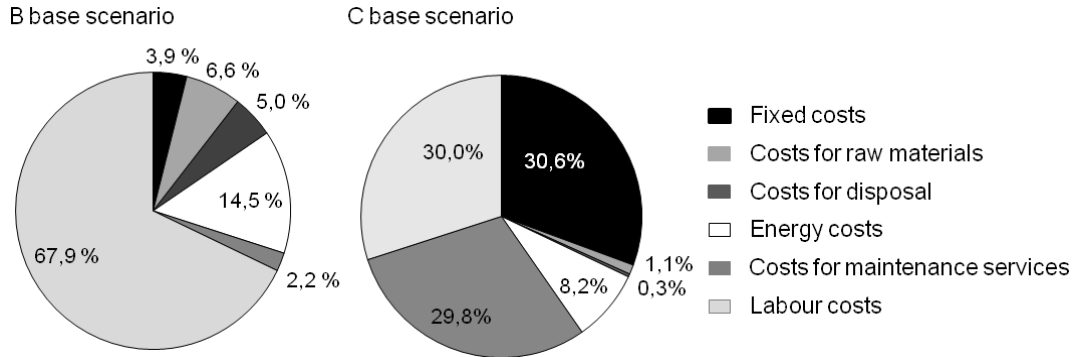
Figure 5. The change in the potential environmental impacts of the continuous process varying the cleaning agent demand in comparison with the batch production